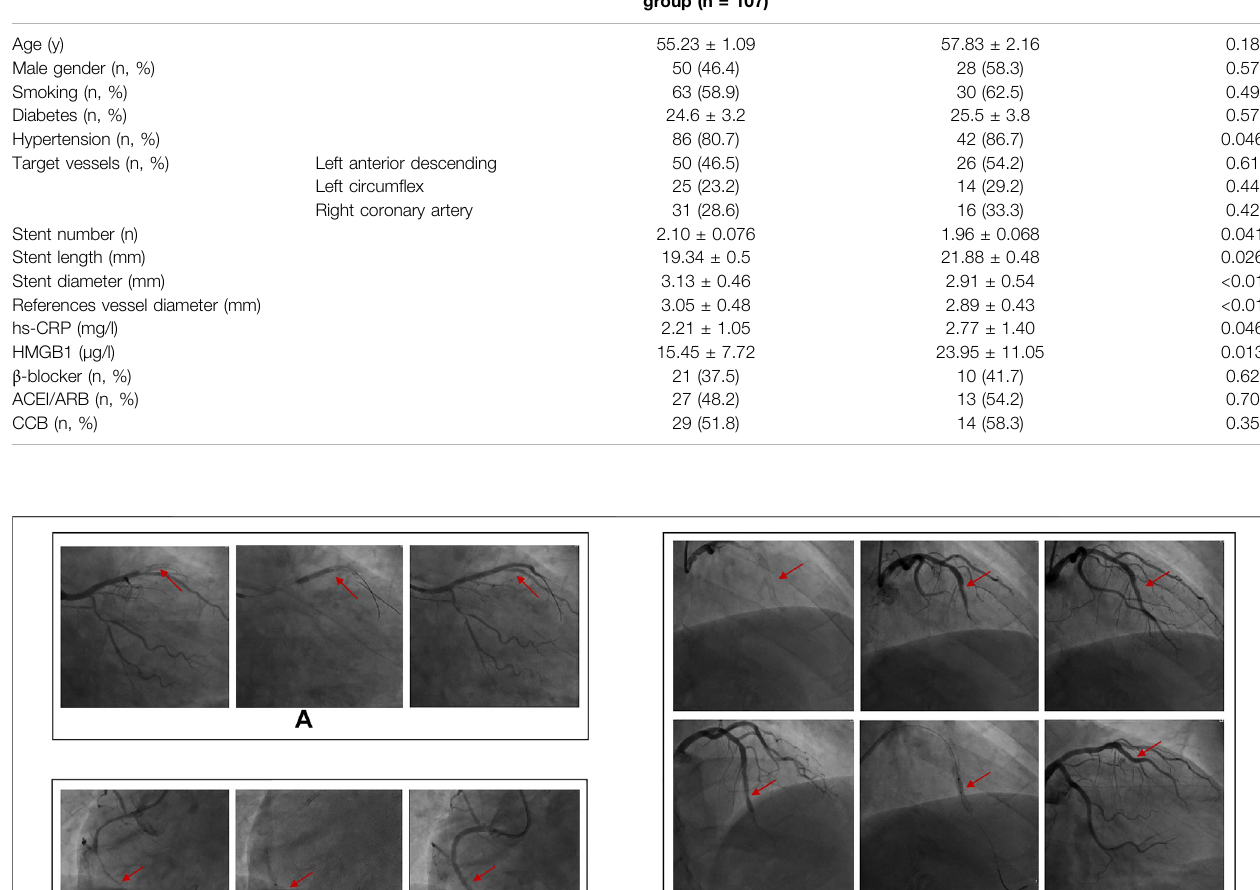
TABLE 1 | Comparison of serum Hcy levels between non ISR group and ISR group. Group